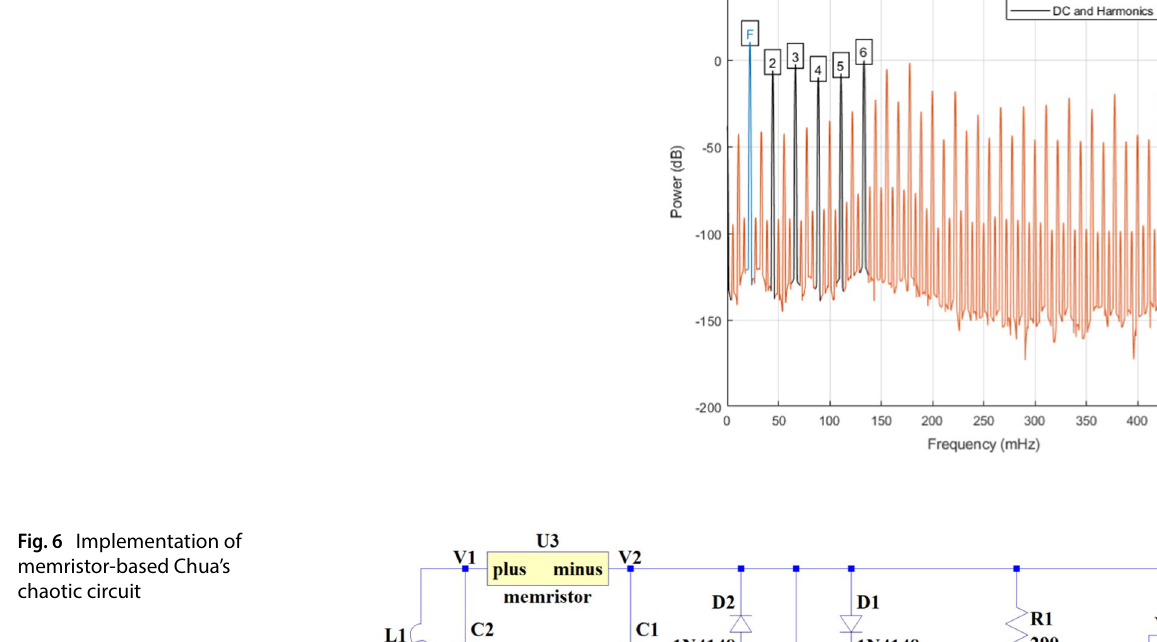
Fig. 5 Signal to Noise Ratio (SNR) for Chua’s signal X